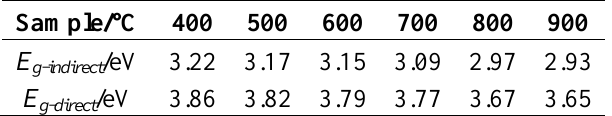
coatings annealed at different 2